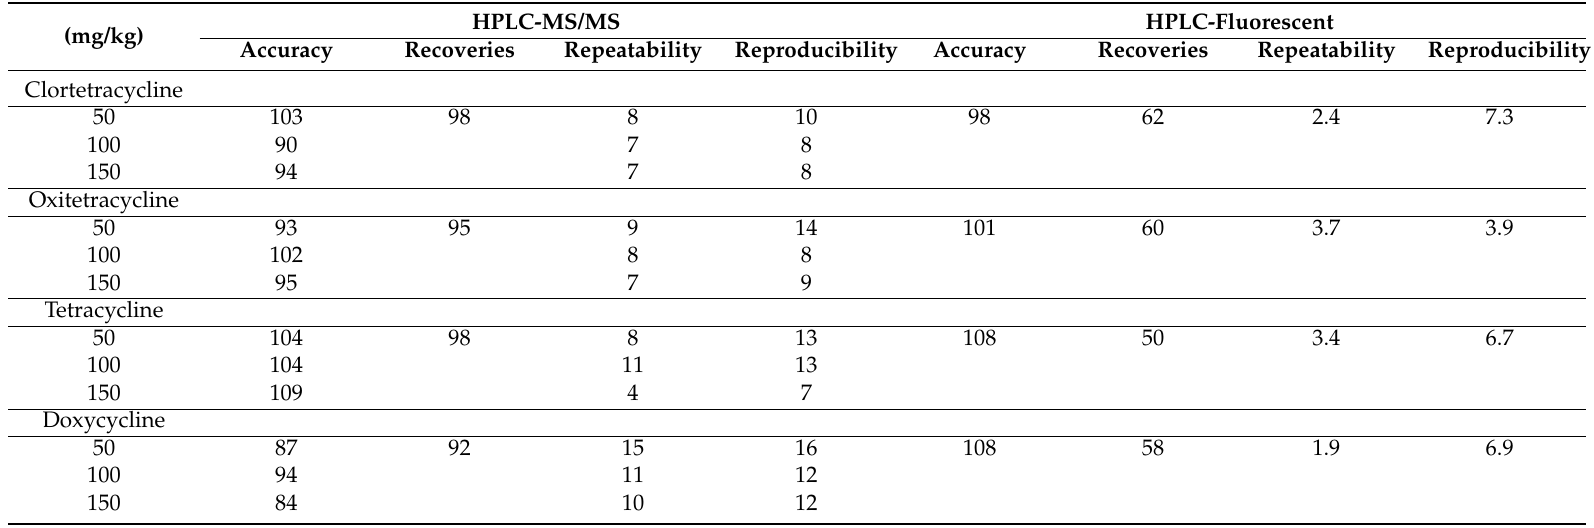
Table 2. Recoveries (%), repeatability (RSD%), within-laboratory reproducibility (RSD%) achieved with the validation of the HPLC-MSMS method and at 50 mg/kg with the HPLC-Fluorescent